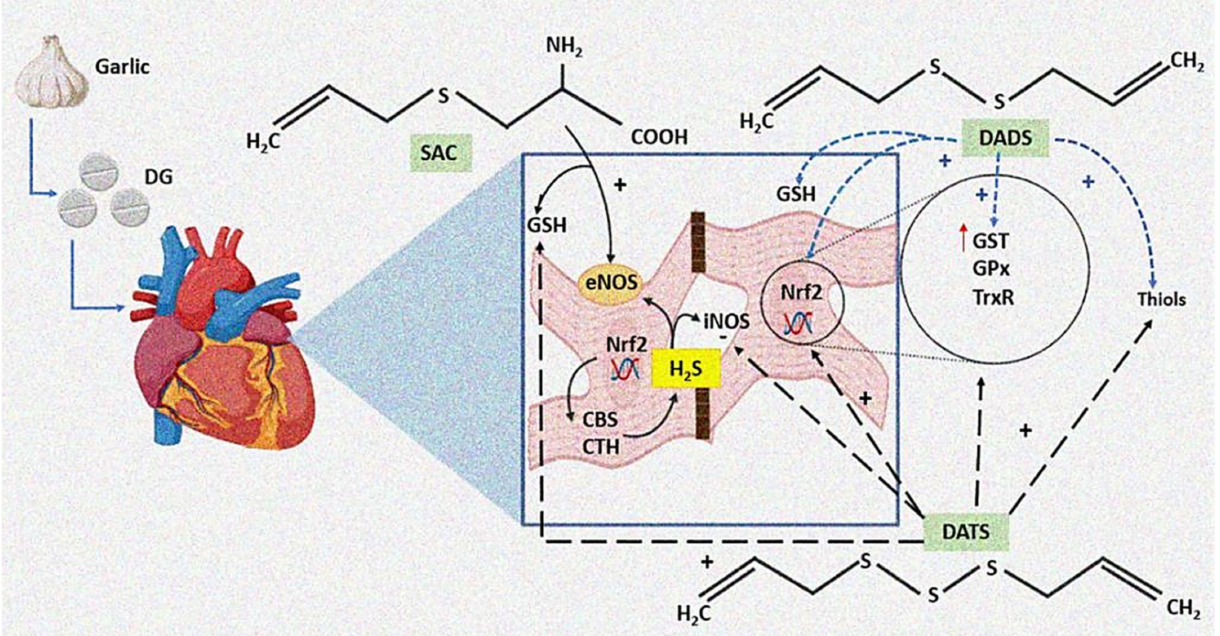
Figure 6. Mechanisms by which DG treatment may down-regulate the negative inotropic and chronotropic effects in the heart in sepsis. A possible mechanistic explanation for the beneficial effect of the DG treatment on the heart is through the H 2 S production. The active organic polysulfides, such as SAC, DADS, and DATS, which are provided by DG, act as H 2 S donors in the presence of thiols and GSH through an increase in the CBS and CTH activity. These polysulfides could also increase the expression of Nrf2 that modulates the overexpression of the antioxidant enzymes, such as eNOS, GST, GPx, and TrxR. Abbreviations: SAC = S-allyl-cysteine, DAS = diallyl sulfide, DATS = diallyl trisulfide, Nrf2 = nuclear factor erythroid 2-related factor 2, CBS = cystathionine β - synthetase, CTH = cystathionine γ -lyase, GSH = glutathione, iNOS = inducible nitric oxide synthase, H 2 S = hydrogen sulfide synthesis, eNOS = endothelial nitric oxide synthase, DG = deodorized garlic, TrxR = thioredoxin reductase, GPx = glutathione reductase, GST =